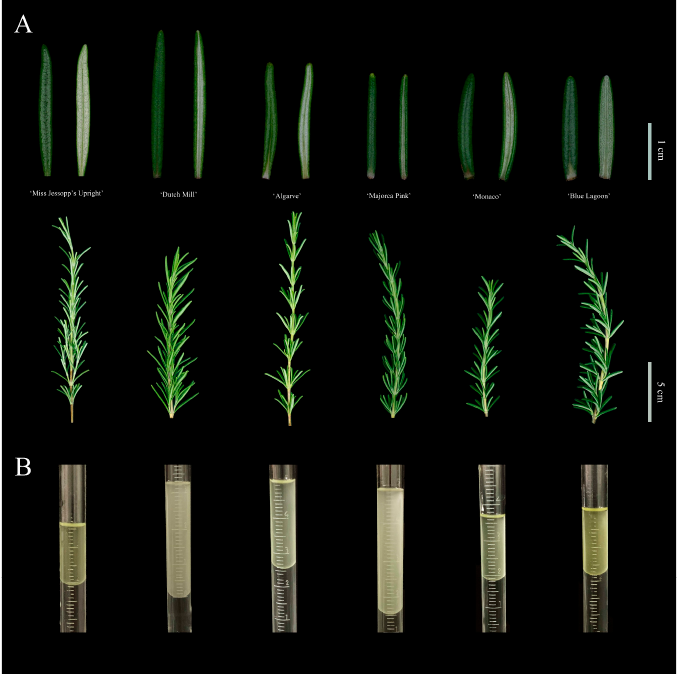
Figure 5. The materials of 6 rosemary cultivars. ( A ) The leaves (adaxial surface and abaxial surface) and branches from 6 rosemary cultivars. ( B ) The REOs extracted from